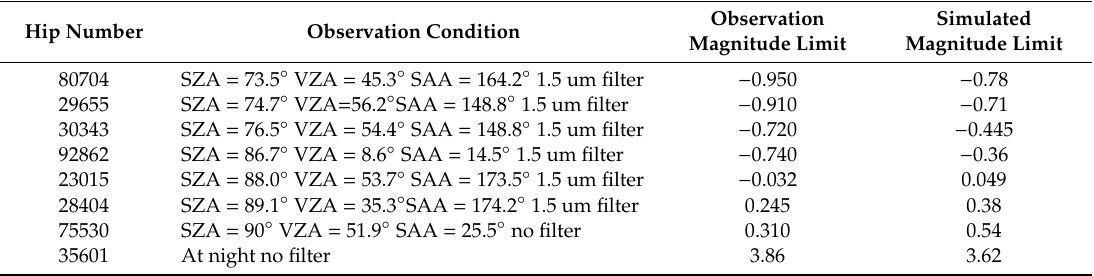
Table 7. Comparison of observation magnitude limit and simulated magnitude limit under di ff erent observation conditions.